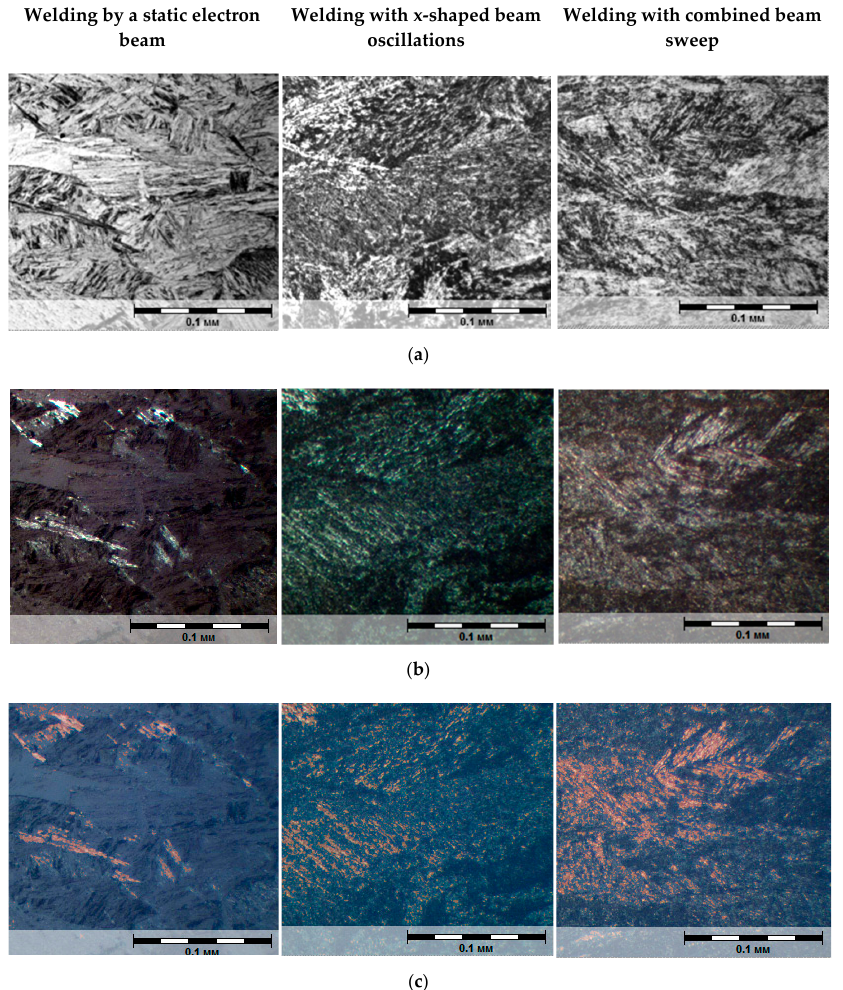
Figure 8. Weld metal microstructure in the middle ( a ) part and an example of determining a percentage ratio of structural components: polarized light ( b ), separating structural components in the VideoTest-Metal program ( c ), × 500. Table 3. Structural composition of weld metal obtained experimentally and by